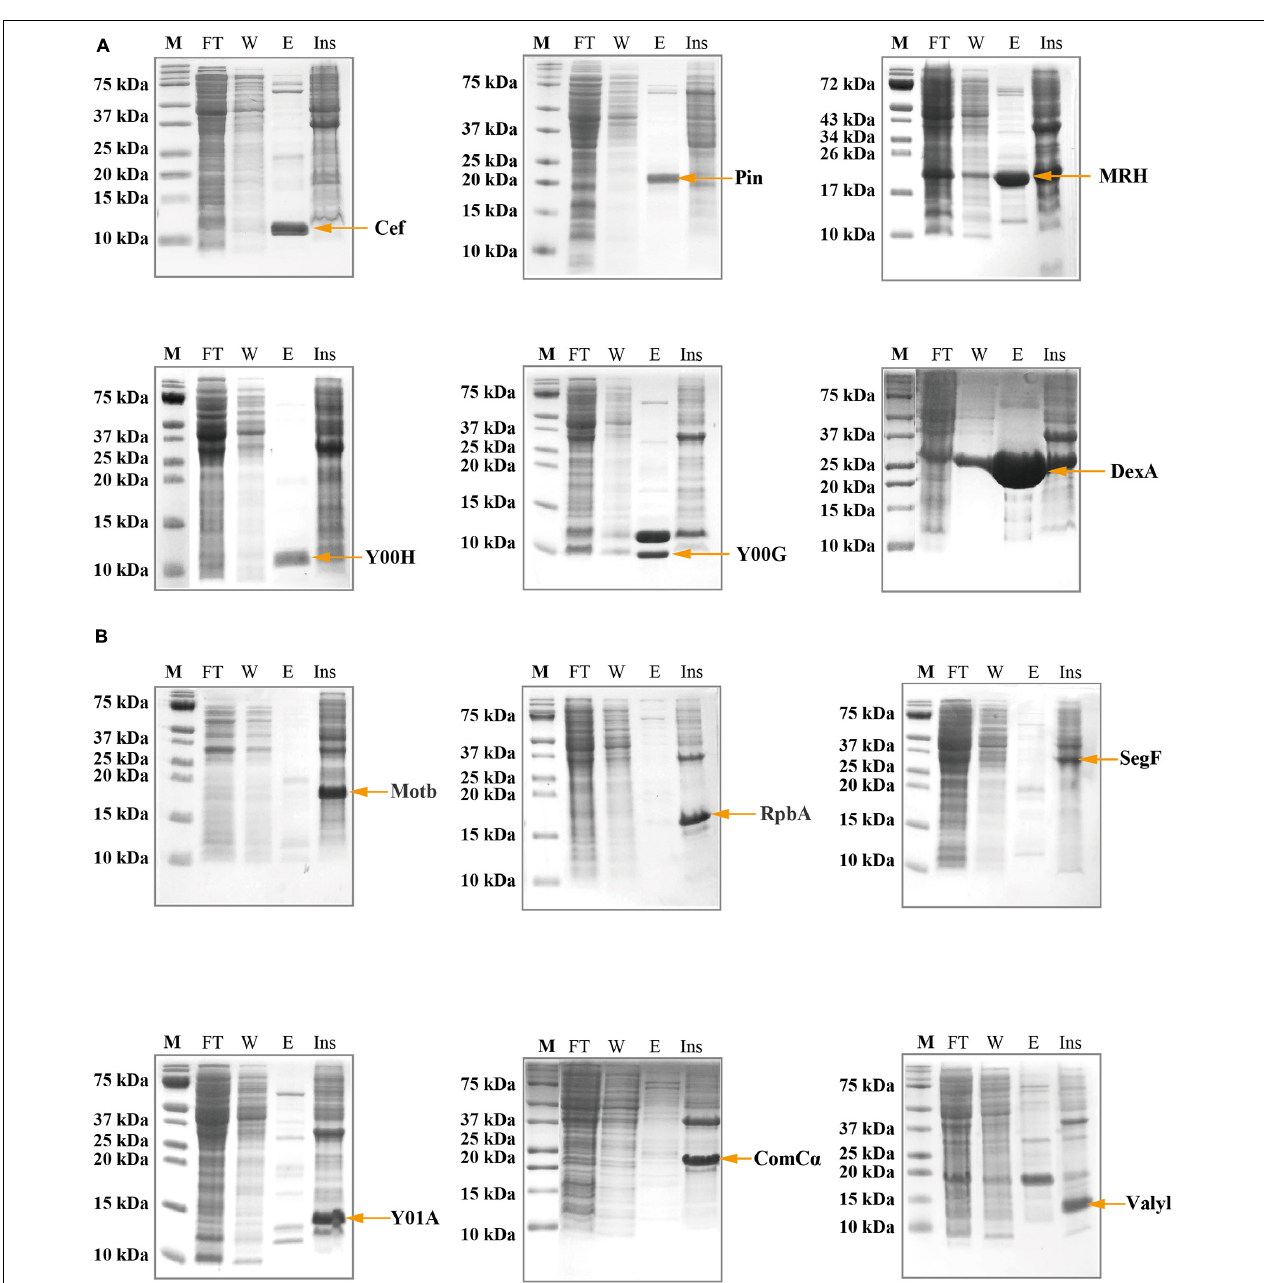
FIGURE 2 | Sodium dodecyl sulfate–polyacrylamide gel electrophoresis (SDS-PAGE) showing the expression and the purification of the viral proteins using N-terminal His-tag. (A) Cef, Pin, MRH, Y00H, Y00G, and DexA proteins were collected in the soluble fraction, evident by the presence of bands of correct molecular weight in the elusion fraction. (B) MotB, RpbA, SegF, Y01A, ComC α , and Valyl proteins were expressed into the inclusion body, evident by the absence of bands of correct molecular weight in the elusion fraction and the presence of the bands in the insoluble fraction. M, Marker; FT, Flow-through fraction; W, Wash fraction; E, elusion fraction; Ins, Resolublized cell debris containing insoluble